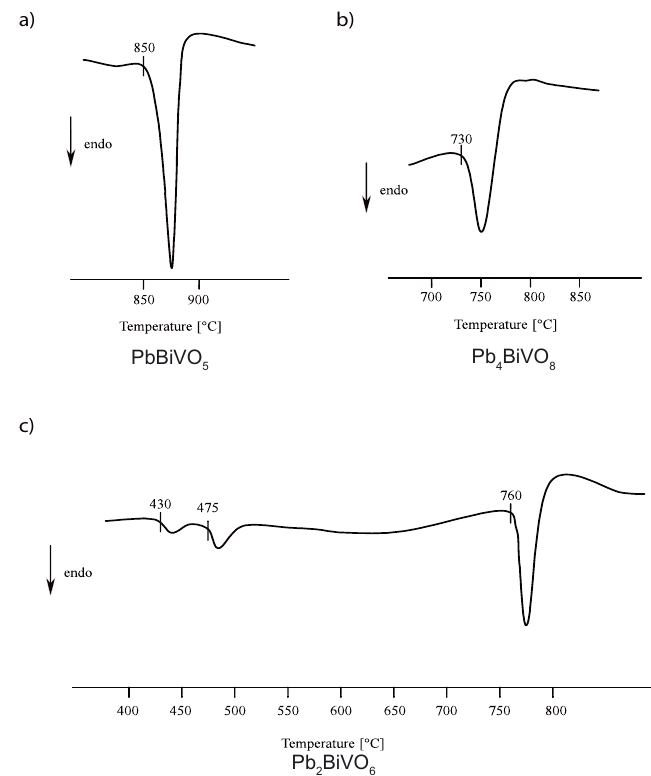
Figure 1. DTA curves of the phases that exist in the system PbO – BiVO